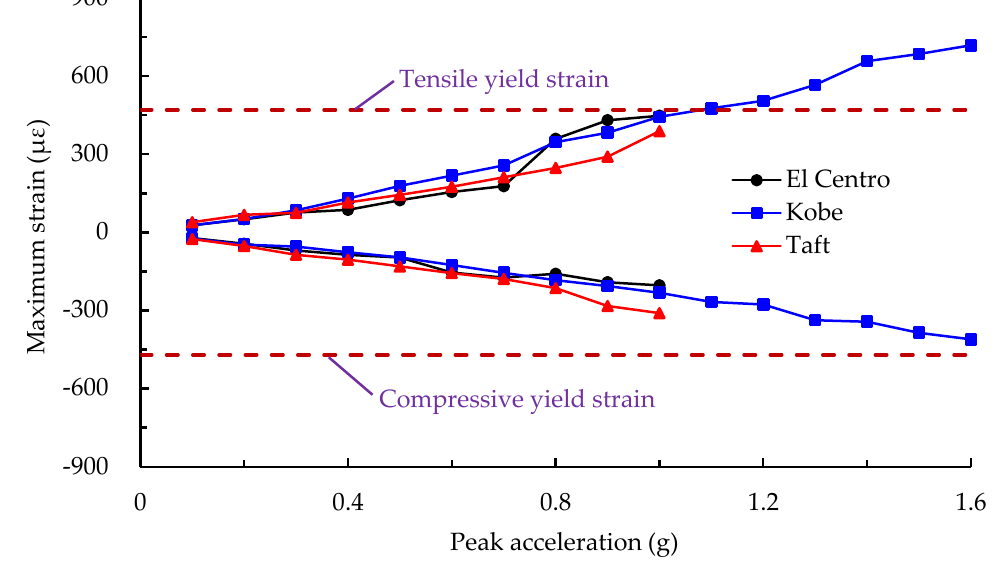
Figure 24. Maximum strains of LYP energy absorbers subjected to different intensity levels.